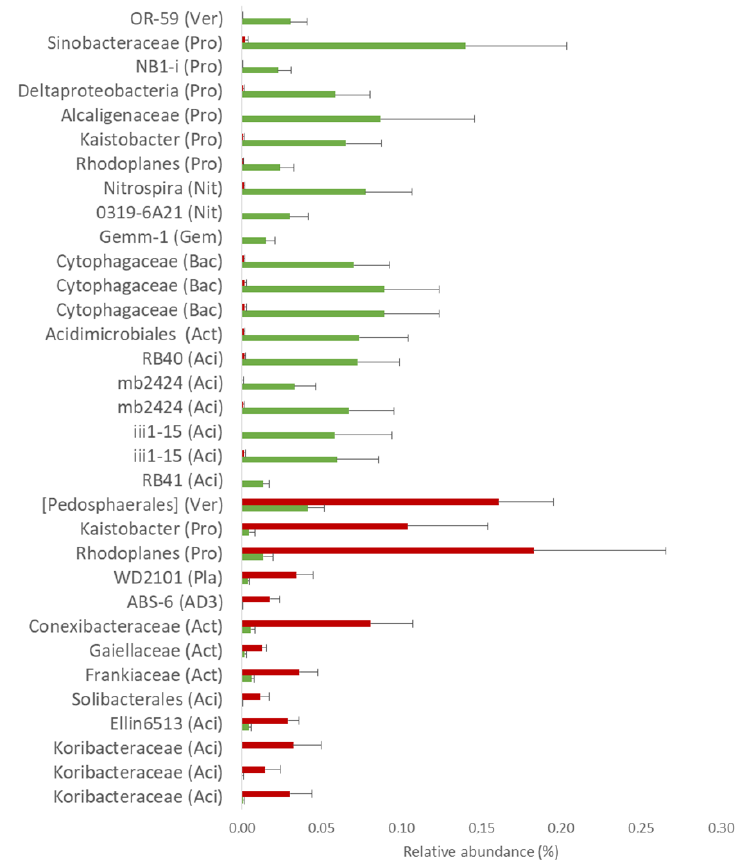
Figure 7. Relative abundance of the common bacterial OTUs, differentially abundant between healthy and AOD oaks across the tree health comparisons. Phyla are indicated in brackets: Ver— Verrucomicrobia; Pro—Proteobacteria; Nit—Nitrospirae; Gem—Gemmatimonadetes; Bac—